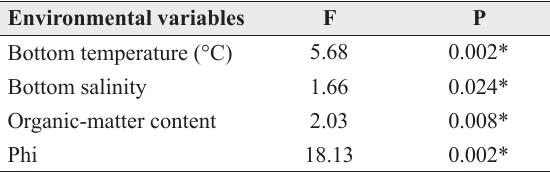
Results of canonical correspondence analysis, showing the probability of significance ( p ) of the environmental